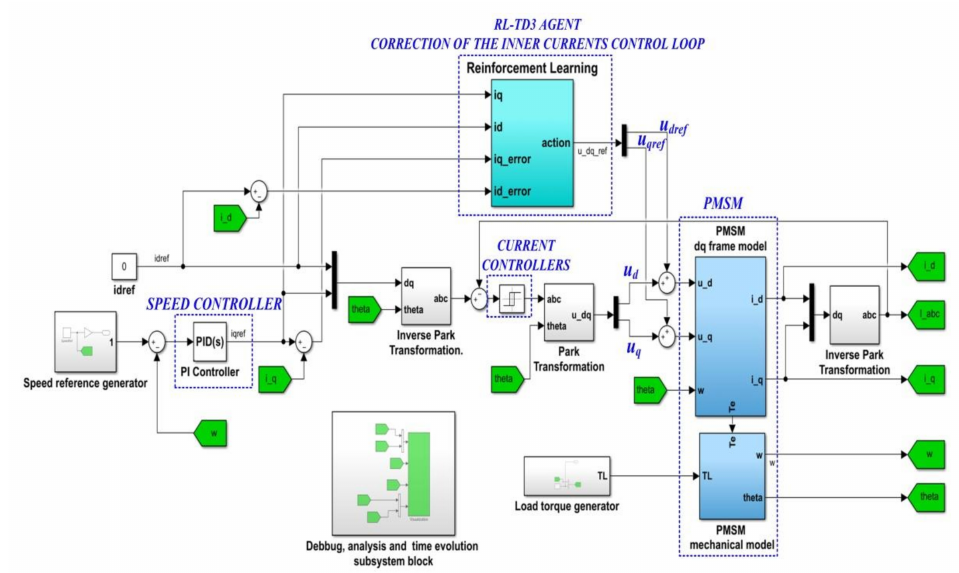
Figure 8. Block diagram of the MATLAB/Simulink implementation for the PMSM control based on PI-type controllers using the RL-TD3 agent for the correction of u dref and u qref